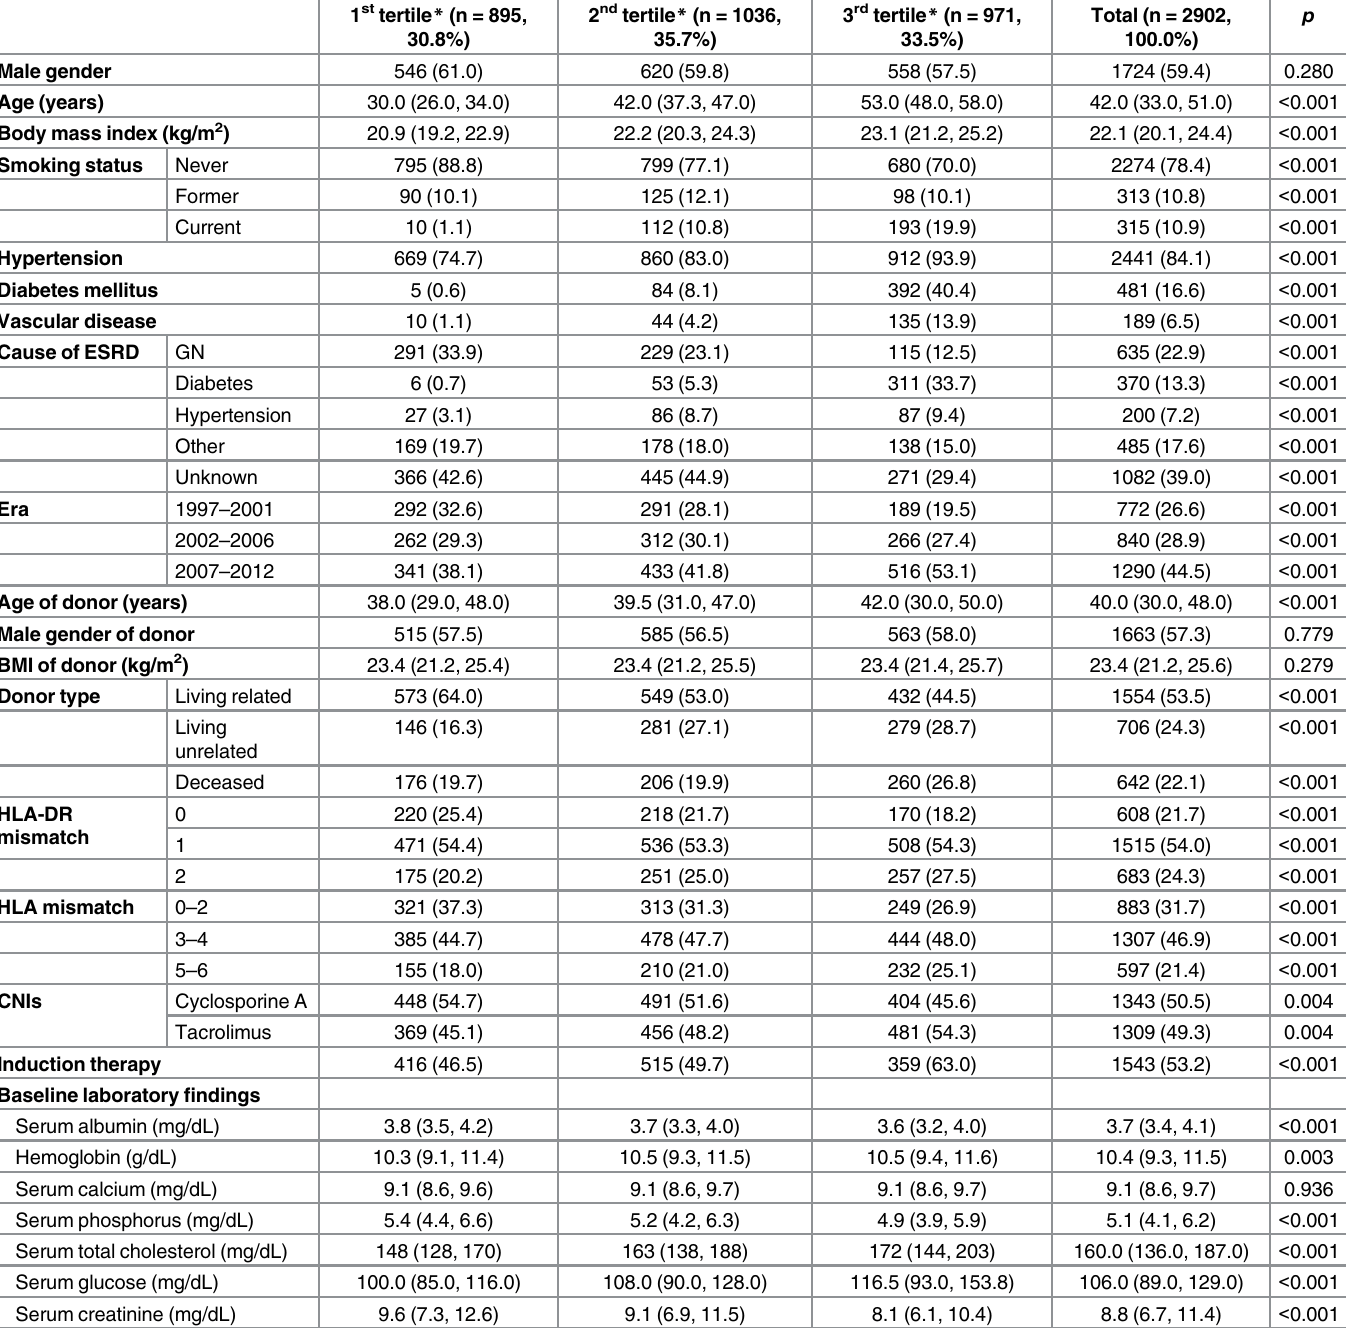
Table 1. Demographics and baseline clinical characteristics according to the tertiles of pre-transplant CV risk